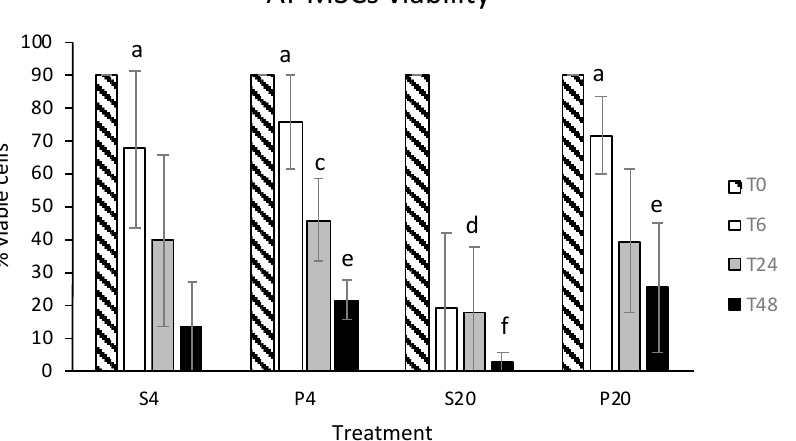
Figure 1. eATMSCs viability after storage for 6 (T6), 24 (T24) and 48 (T48) hrs in saline solution (S) and plasma (P) at 4 ◦ C (4) and room temperature (20): a vs. b; c vs. d; e vs. f: p <